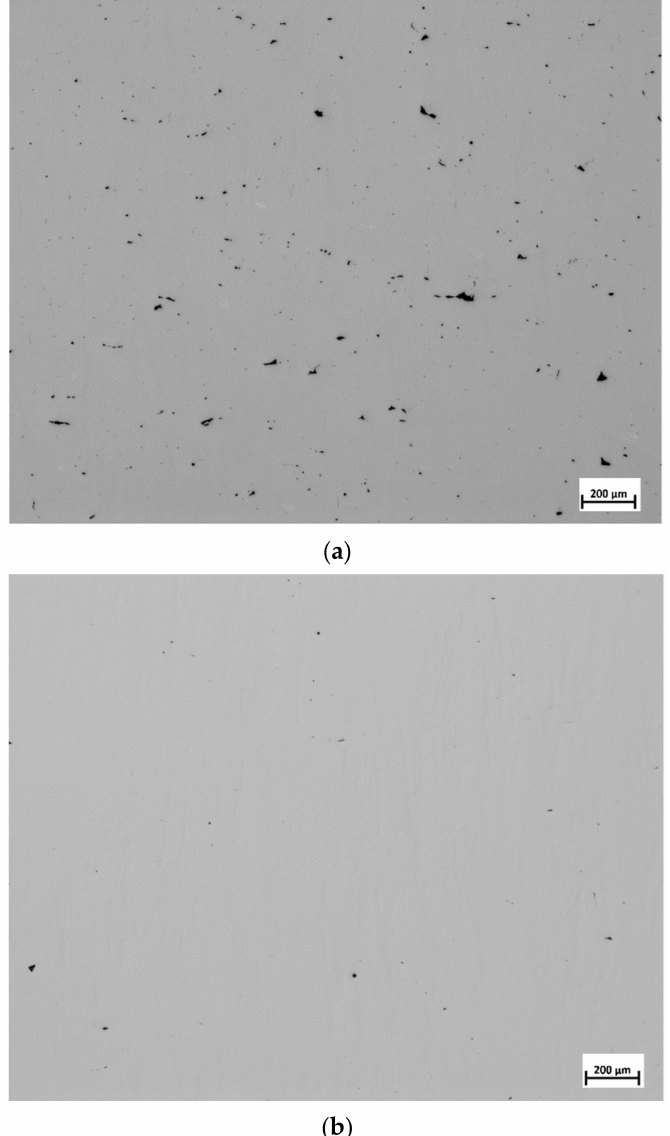
Figure 3. Typical optical micrographs showing noticeable di ff erence in the void contents among the samples: ( a ) Sample 22; ( b ) Sample